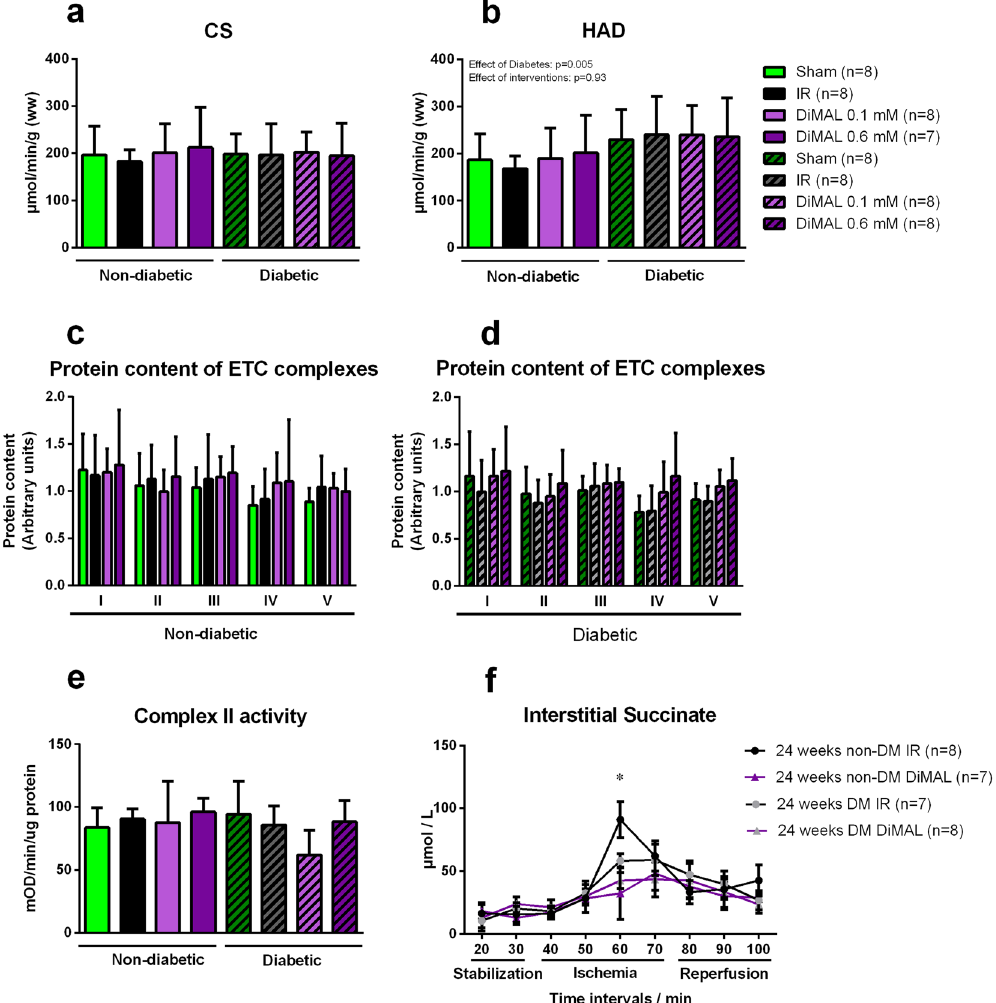
Figure 8. Isolated rat heart study - Mitochondrial enzyme activity. Enzyme activity of citrate synthase (CS) and β -hydroxyacyl-CoA dehydrogenase (HAD) ( a,b ). Below protein content of individual electron transport chain complex I-V in non-diabetic ( c ) and diabetic ( d ) heart tissue. At the bottom Complex II activity in non-diabetic and diabetic tissue ( e ) and interstitial succinate concentrations ( f ). IR: Ischemia reperfusion, DiMAL: Dimethyl malonate. Data are the mean ± SD. * P < 0.05 between indicated groups. P-values at the top indicate overall effect of diabetes and interventions by two-way ANOVA,